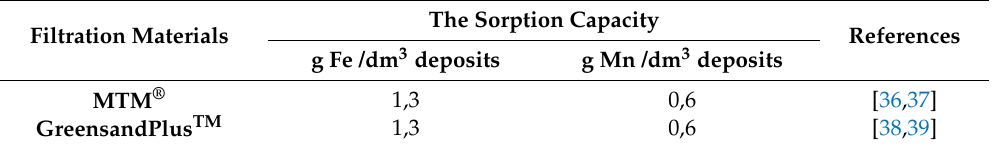
Table 6. The of chemically active filtration materials based on silica carriers. Filtration